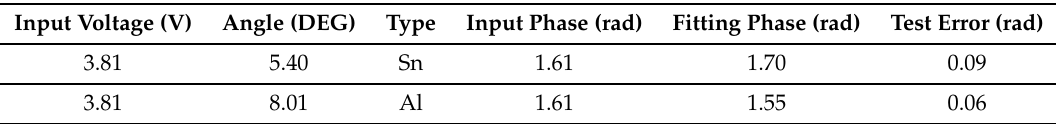
Figure 11. Test results (N is the order of testing) where red cross denotes the wrong test. ( a ) Phase error versus N. ( b ) Angle error versus N. Table 2. Data about the wrong test.